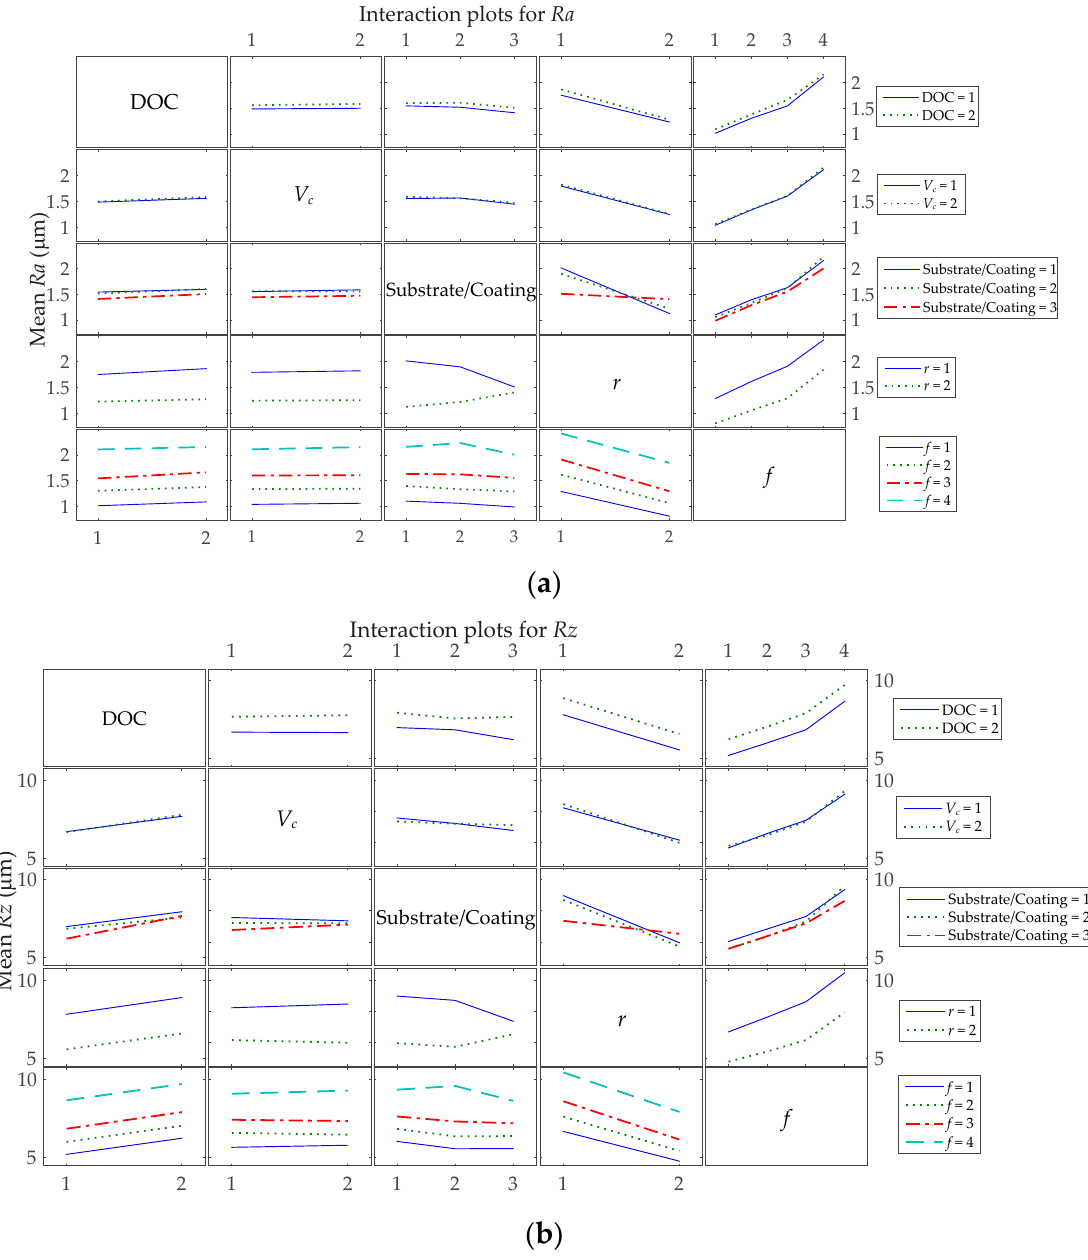
Figure 4. Interaction plots for surface roughness means: ( a ) Ra ; ( b ) Rz .